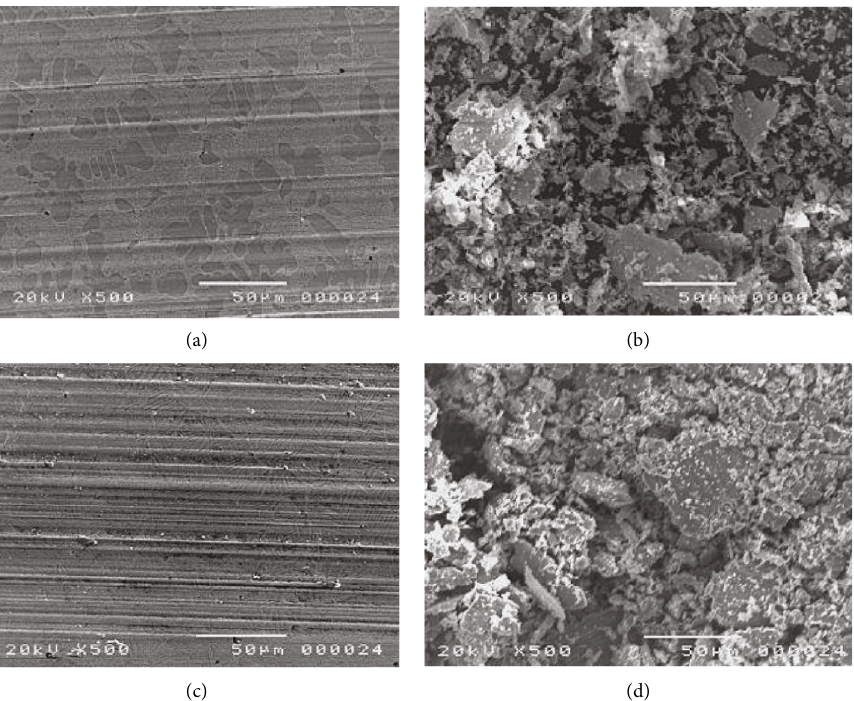
Figure 19: Worn surface and worn debris of AlCoCrFexMo0.5Ni alloys with different Fe contents: (a) x � 0.6, worn surface; (b) x � 0.6, worn debris; (c) X � 2.0, worn surface; (d) x � 2.0, worn debris [32].